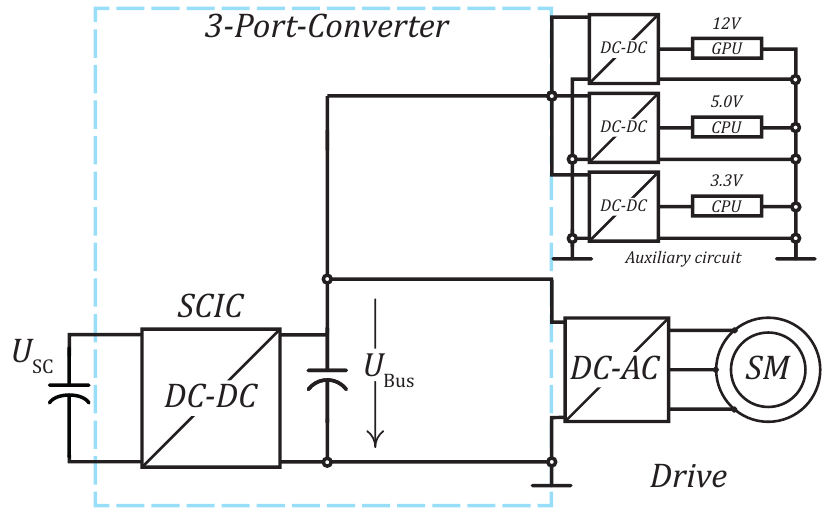
Figure 8. Topology IV: Interface converter between the super-capacitor and auxiliary circuits.